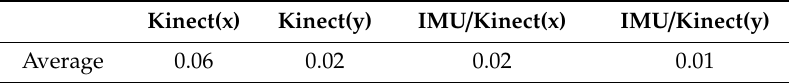
Table 6. Absolute values of the coordinate errors (in meters).